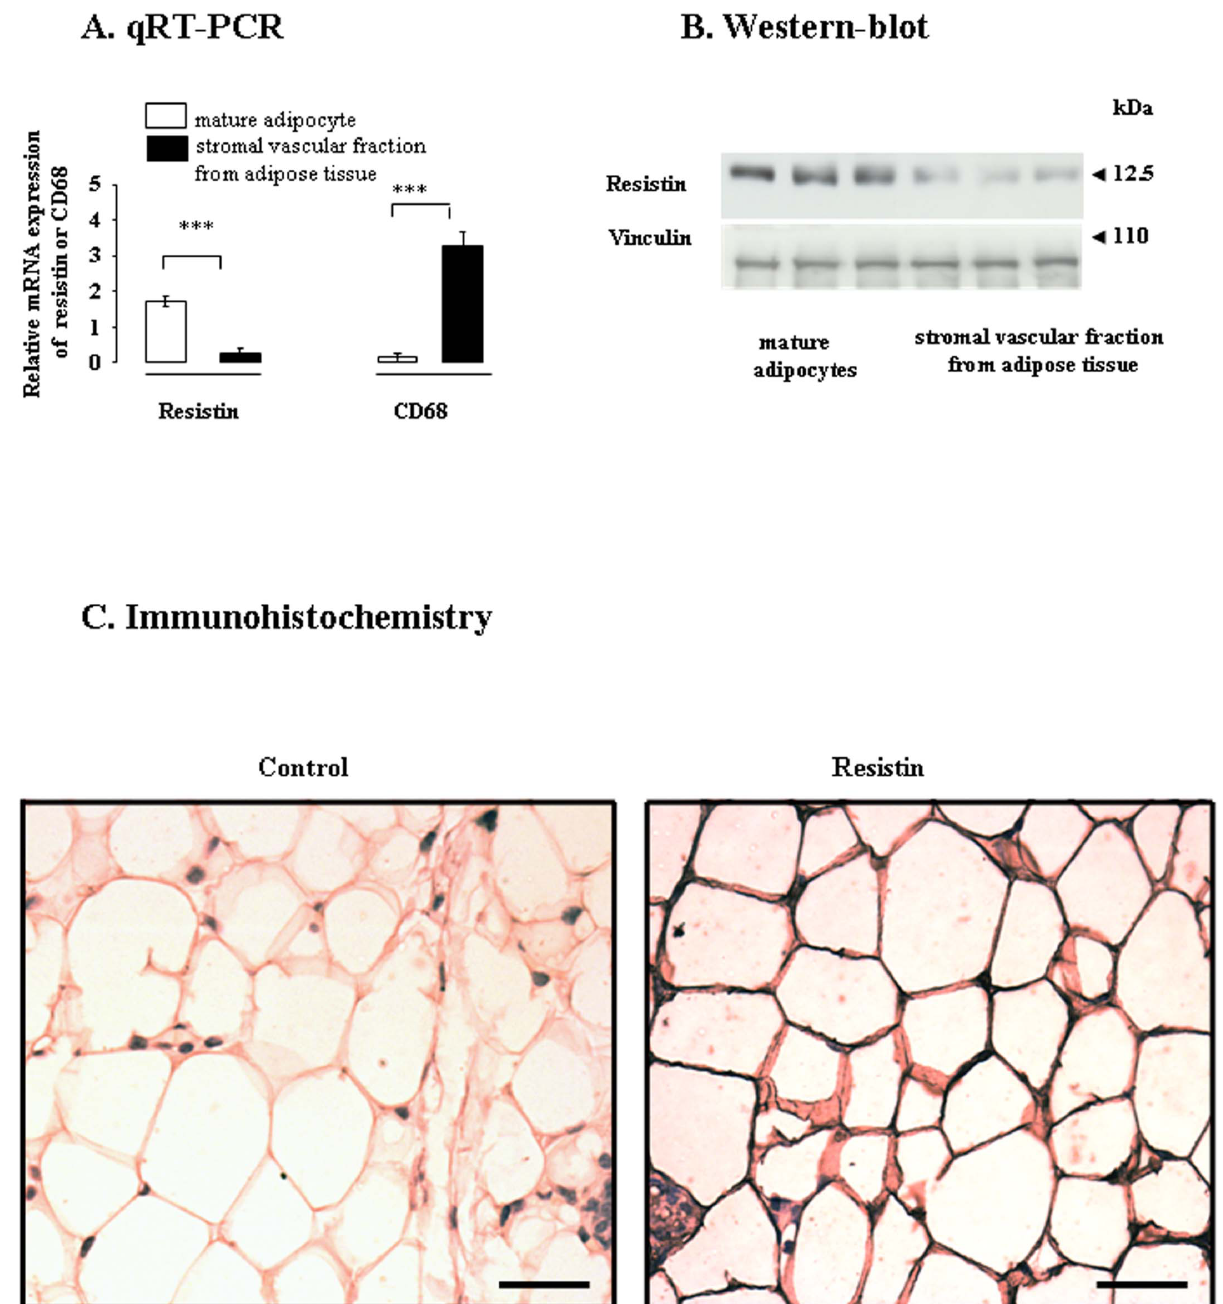
Figure 6. Immunolocalization and levels of resistin protein in bovine adipocytes. Levels of mRNA (A) and protein (B) for resistin in isolated mature bovine adipocytes and in isolated bovine stromal vascular cells, as determined by qRT-PCR and western blotting, respectively. mRNA levels for CD68 (the main cell surface marker of macrophages) was also measured in in isolated mature bovine adipocytes and in isolated bovine stromal vascular cells (A). Relative expression was measured relatively to the geometric mean of 4 reference gene expression [cyclophilin A (PPIA), GAPDH, Actin B (ACTB), and ribosomal protein L19 (RPL19)] by real-time reverse-transcription PCR. Vinculin (VLC) was used as the loading control for immunoblotting. The results are representative of five cell preparations (adipose tissue from one cow was used for one cell preparation). Results are represented as means 6 SEM. * indicates a significant difference ( p , 0.05). C. Subcutaneous white adipose tissue from 32-month-old cows was fixed and sectioned, and then subjected to immunochemical analysis to determine of the distribution of resistin. Bar: 100 m m. The image shown is representative of three experiments on three different animals. doi:10.1371/journal.pone.0093198.g006 vitro mRNA expression of ATGL and HSL mRN on adipose tissue explants suggesting that resistin could also act independently of GH.